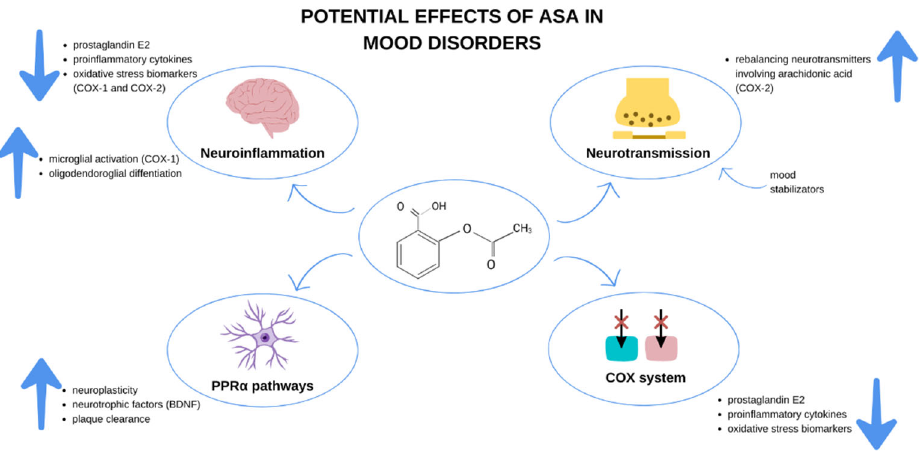
Figure 8. Potential mechanisms of action in mood disorders.